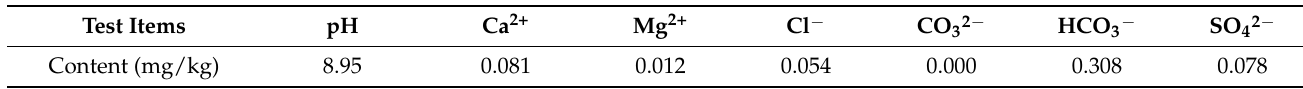
Table A10. Corrosion analysis of